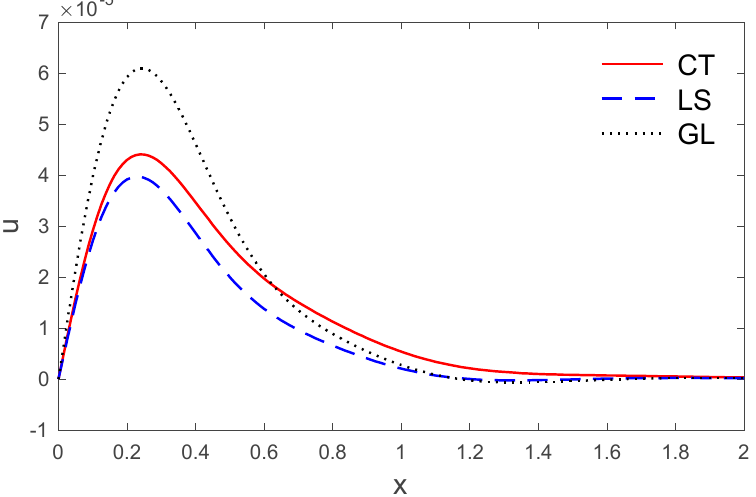
Figure 8. The horizontal displacement variation 𝑢 via 𝑥 , with y = 0.5 under the three models.